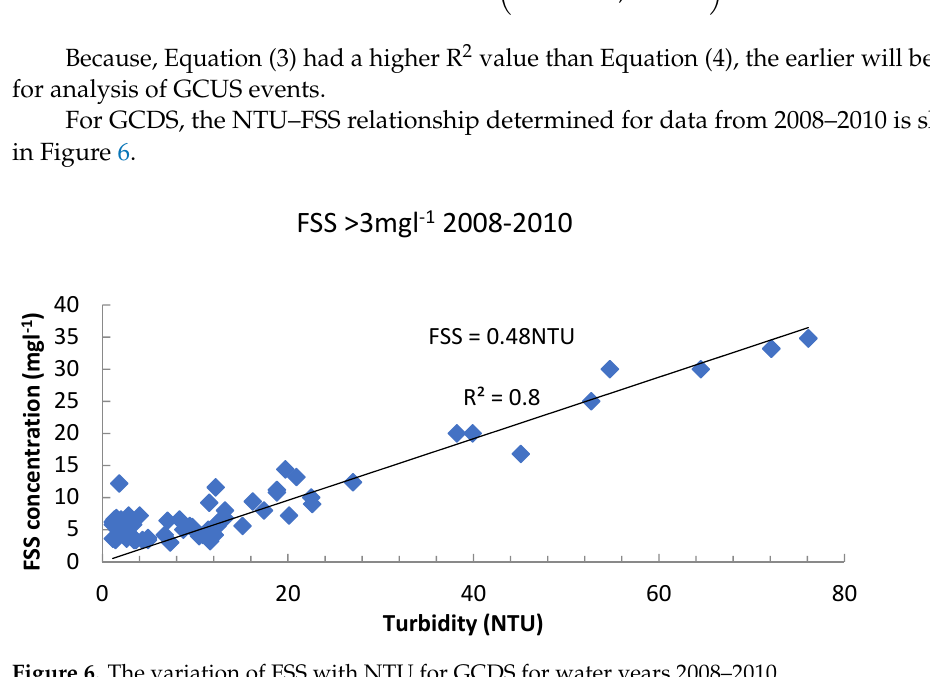
Figure 6. The variation of FSS with NTU for GCDS for water years 2008–2010. The relationship at GCDS derived by Moliere et al. [41] using data between 2005 and 2007 is: Because the relationship derived by Moliere et al. [41] in Equation (5) had a higher R 2 value than determined for the data in Figure 6, the relationship derived by Moliere et al. [41] was used for deriving FSS for analysis. No new FSS data were available for MCUS and MCDS. Therefore, the relationship between NTU and FSS derived by Moliere et al. [36] using the data between 2006 and 2008 was used to derive FSS for all the Magela Creek data.